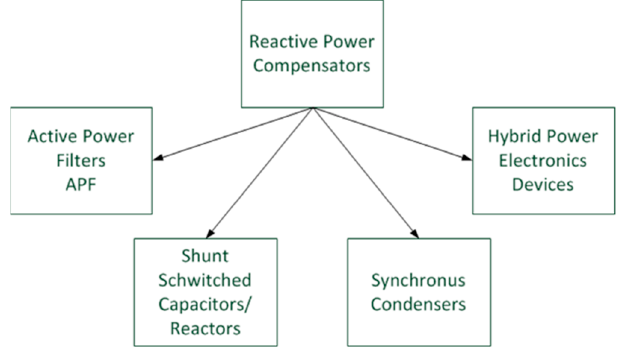
Figure 1. Classification of reactive power compensation devices.